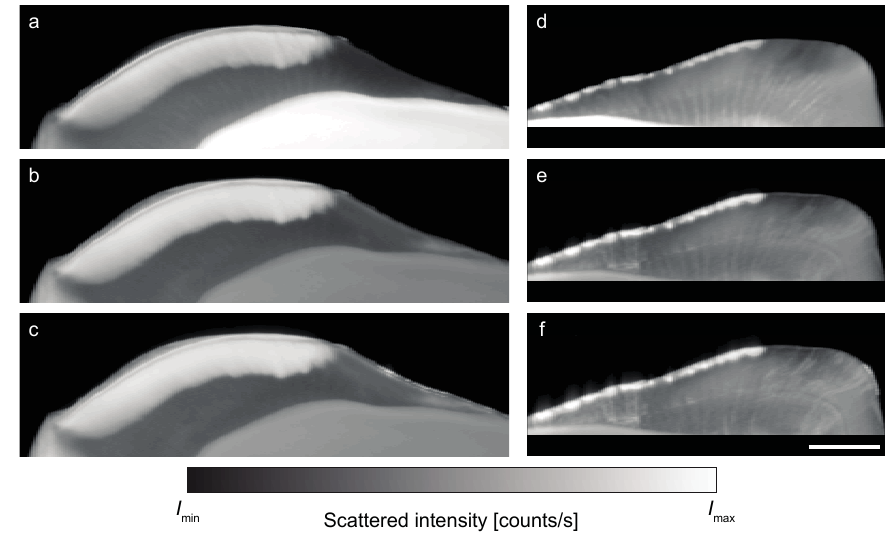
Figure 3. Integrated scattered intensity for the q -ranges that corresponds to the real-space periodicities between 10 and 20 nm ( a , d ), 70 and 80 nm ( b , e ), and 140 and 150 nm ( c , f ) for the natural (left column) and the artificial (right column) lesions. For all ranges, the lesion appears as bright band in the upper part of the image, corresponding to high scattering intensity. The enamel yields lower scattering intensities compared to dentin and lesion. The intensities are logarithmically scaled with I min and I max corresponding to ( a ) 2.0–53.3, ( b ) 0.2–10.0, ( c ) 33.4–26,500.0, ( d ) 8.4–2,650.0, ( e ) 66.7–133,000.0, and ( f ) 21.1–13,000.0 counts per pixel, respectively. The length bar corresponds to 1 mm.